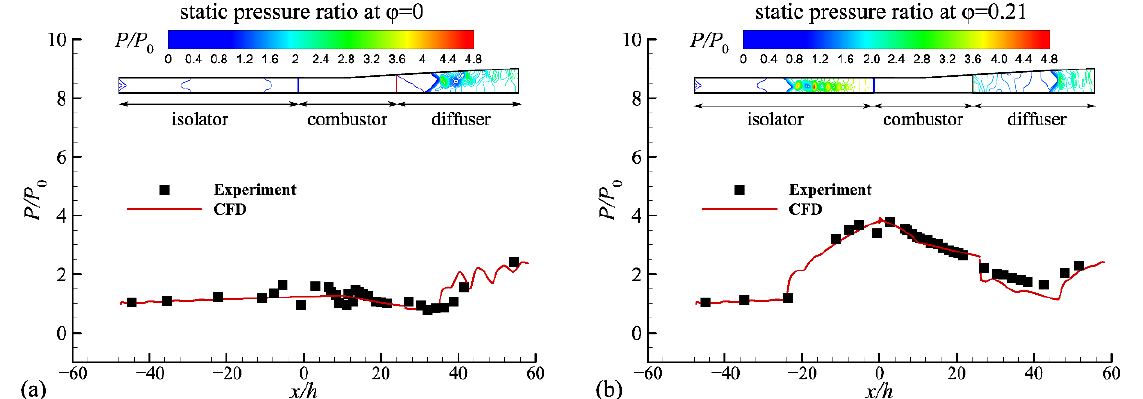
Figure 5. Multifidelity simulations compared to wind tunnel tests. ( a ) Static pressure distribution along the combustor and pressure contour at a fuel equivalence ratio of 0; ( b ) static pressure distribution along the combustor and pressure contour at a fuel equivalence ratio of 0.21.